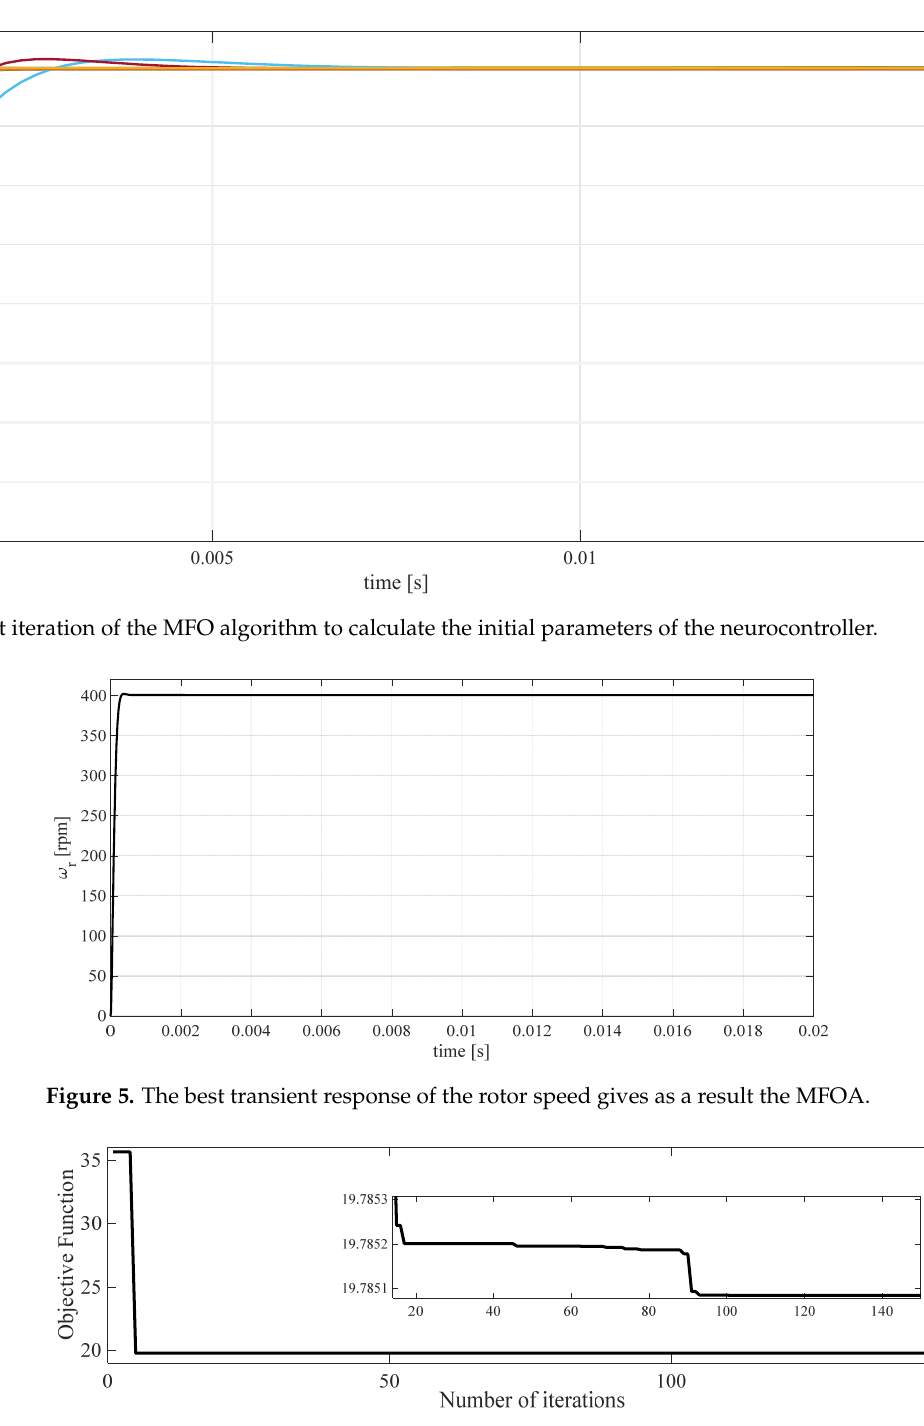
Figure 6. The objective function with respect to iteration numbers of MFO algorithm.